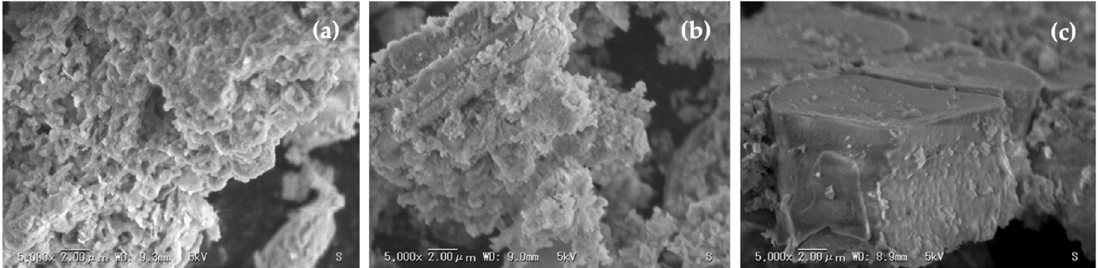
Figure 5. Morphologies of corn stover ash and related phases achieved by pretreatments. ( a ) Raw corn stover ash, as received, ( b ) calcined corn stover ash, and ( c ) acidified corn stover ash.